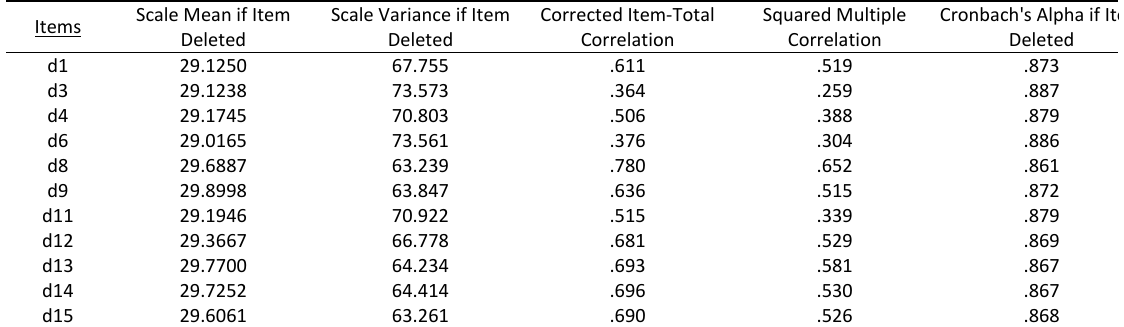
Table 3: Item-Total Statistics